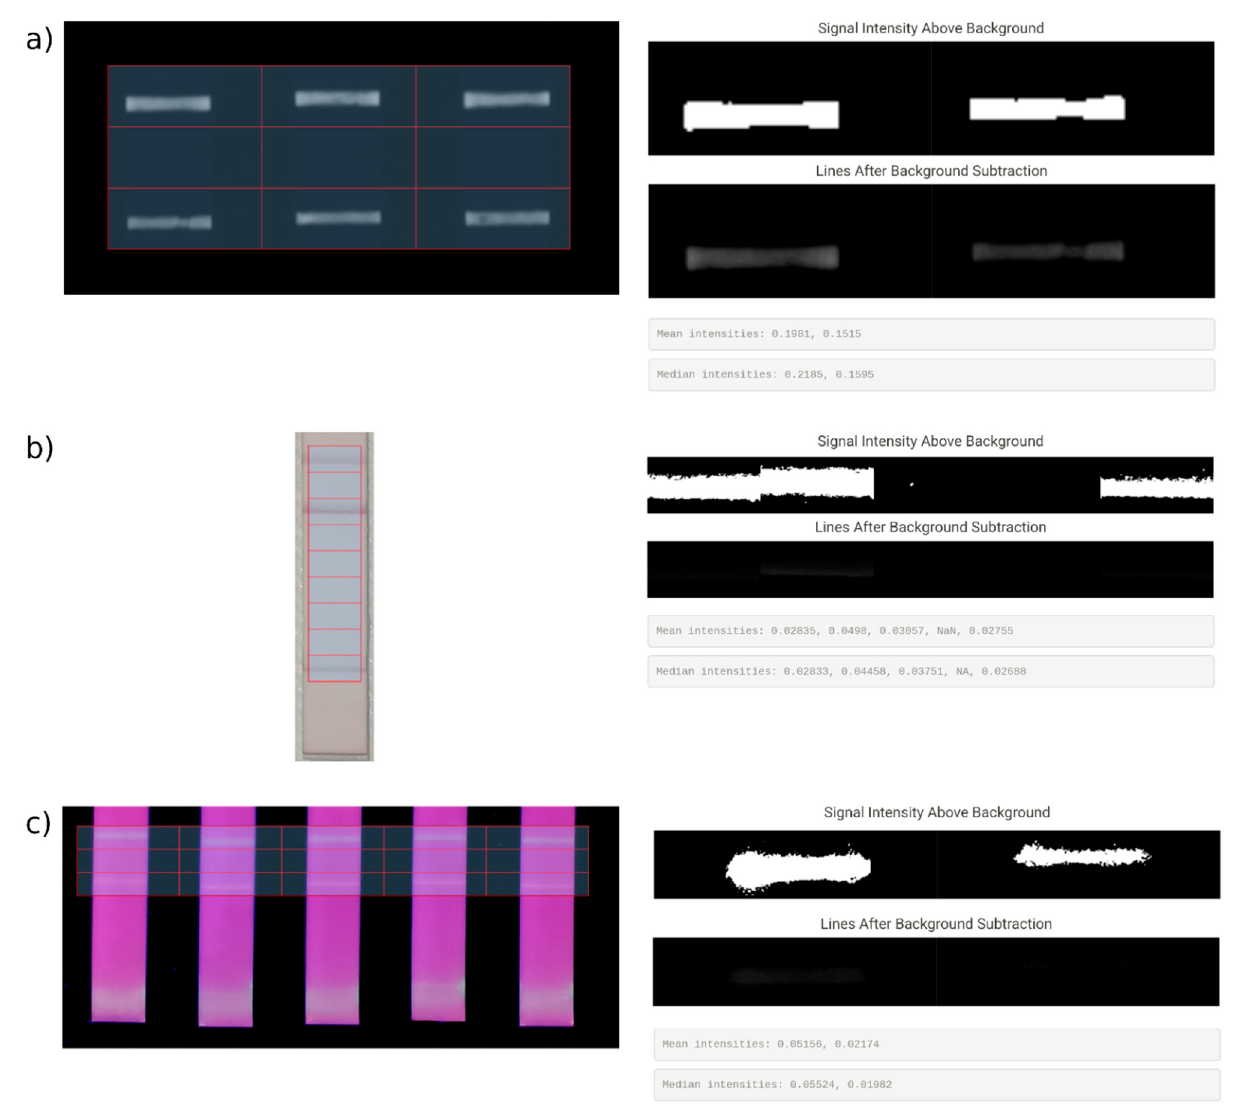
Figure 3. Background correction with three example images; ( a ) a grayscale LFA image acquired via BioImager ( left ) and its background correction results ( right ), ( b ) a colour LFA image taken with a smartphone ( left ) and its background correction results ( right ) and ( c ) a multicolour LFA image acquired with our smartphone imager ( left ) and its background correction results ( right ).